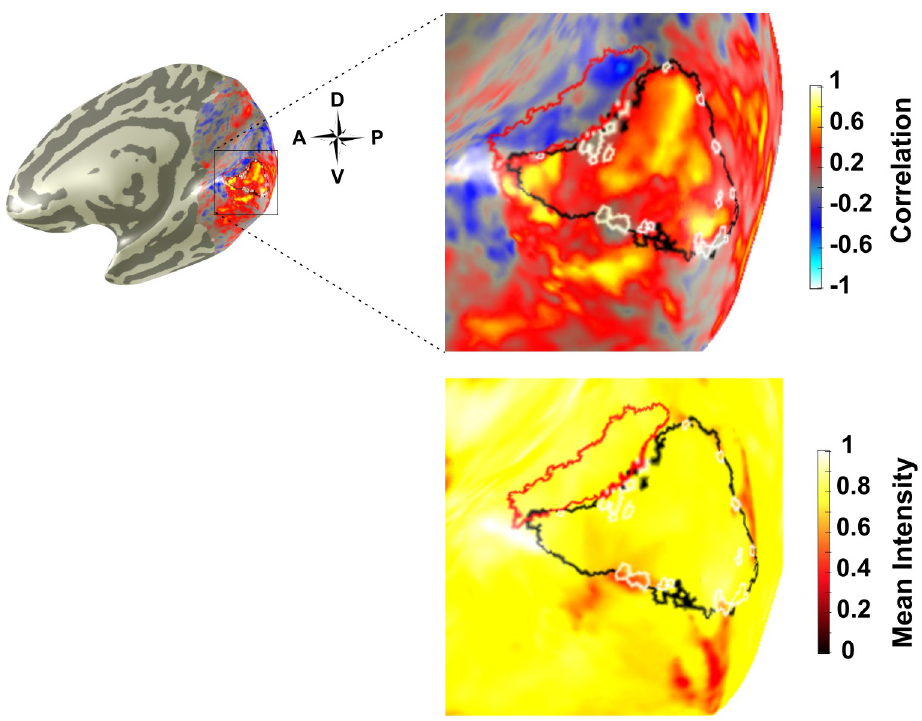
Fig 11. Right hemisphere correlation and mean intensity map from Subject 5 showing ROIs of NBRs outside V1 (red), V1 (black) and inverted voxels within V1 (white). Note the stronger negative correlation values of the NBRs vs. the inverted voxels in the correlation map, in addition to the stronger mean intensity values of the NBRs vs. the inverted voxels in the mean intensity map.